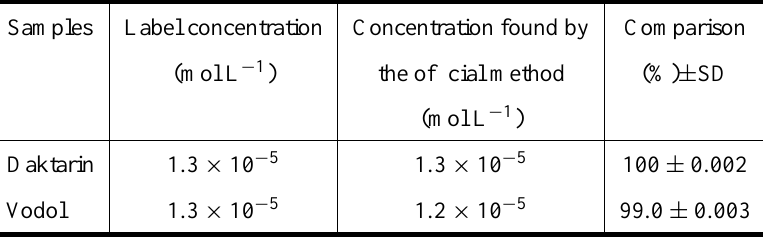
Analysis of miconazole in pharmaceutical formulations by spectrophotometric method (Cavrini et al.